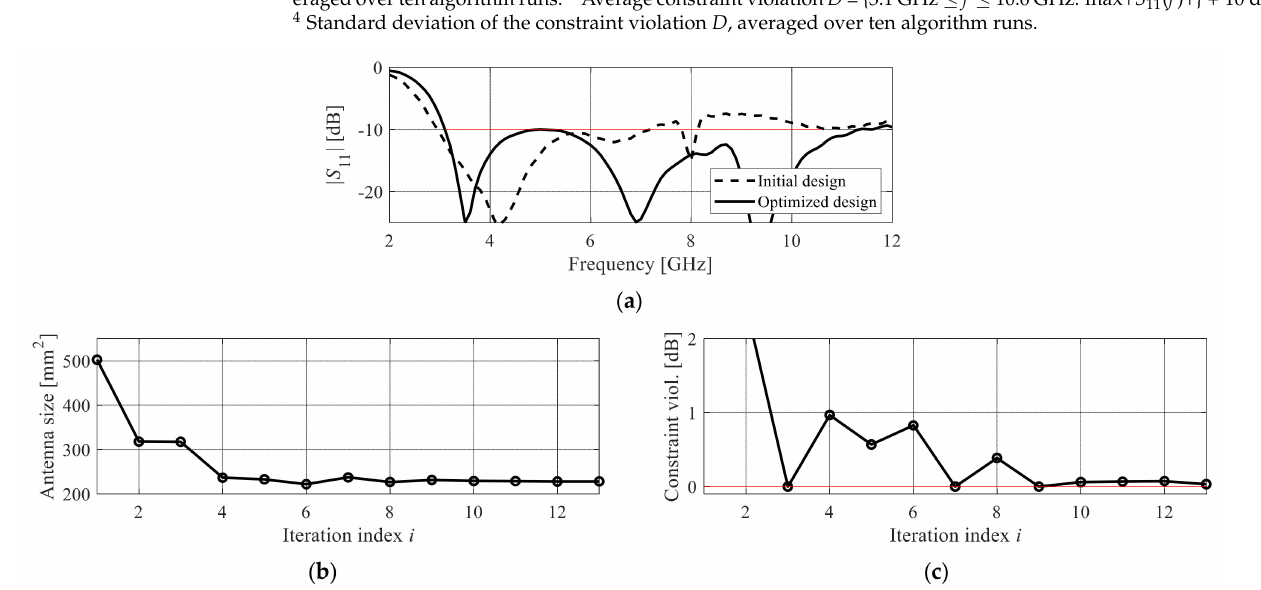
Figure 12. Representative run of the algorithm [44] optimizing the antenna of Figure 11: ( a ) antenna reflection characteristics at the initial (- - -) and optimized design (—), ( b ) evolution of antenna size, ( c ) evolution of constraint